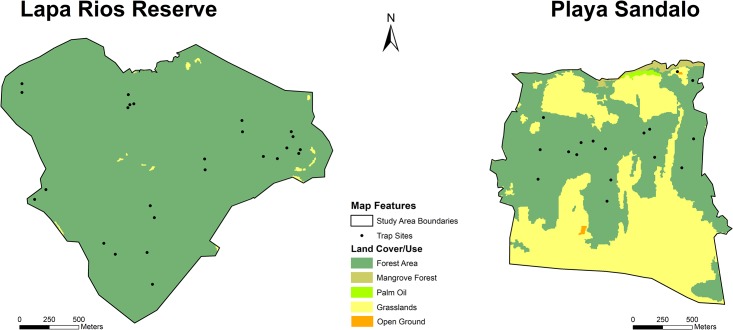
Trap sites and land cover/use within study area´s boundaries.Trap sites include 25 and 16 sites for Lapa Rios and Sandalo, respectively. High frequencies of dense forested areas, including mangrove forests in Playa Sandalo, and non-forested areas such as grasslands, palm oil, or open ground, were evaluated using land cover/use data provided by the Inogo Initiative (http://inogo.stanford.edu). Depicted boundaries were created by this study using spatial features (i.e. roads and forest edges).